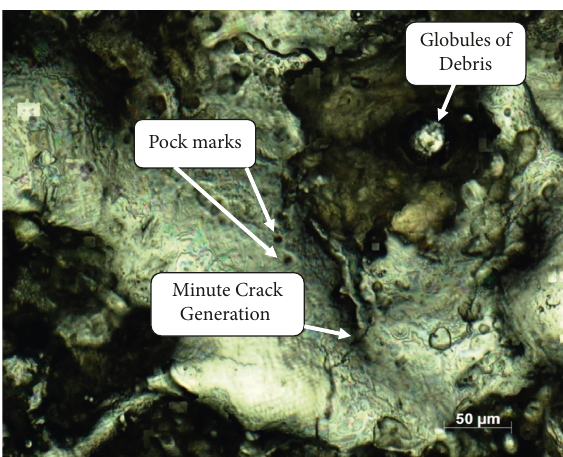
Figure 15: Analysis of surface topography for experimental run 1 using the initial